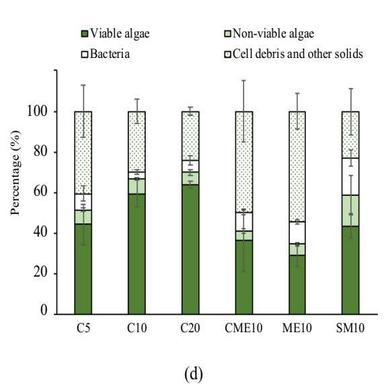
Average values of (a) cell counts and (b) MLSS for different cultures with controlled bacterial addition, and comparison of (c) microalgal population distribution and (d) biomass composition of the mixed cultures with or without controlled bacterial addition after Day 20 (n = 15), with error bars displaying the corresponding standard deviation.